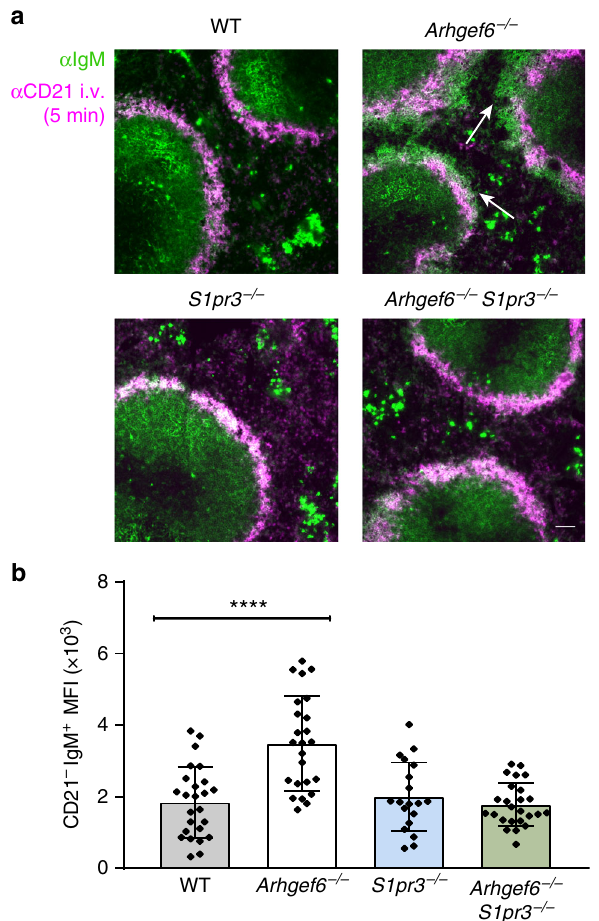
Fig. 8 Translocation of α PIX knockout MZB toward the red pulp is rescued by co-deletion of S1PR3. a Immuno fl uorescence microscopy of IgM + cells located beyond the CD21-positive boundary of the marginal zone (white arrows) in wild-type (WT), Arhgef6 − / − , S1pr3 − / − , and Arhgef6 − / − S1pr3 − / − chimeric spleens. Scale bar, 50 µ m. b Quanti fi cation of mean fl uorescence intensity (MFI) of CD21 − IgM + cells inside a band of 60 µ m beyond the marginal zone, itself calculated as a band of 60 µ m outside of MAdCAM-1 staining. Bars show mean ± SEM. Data represent two independent experiments with three bone marrow chimeric mice per genotype.